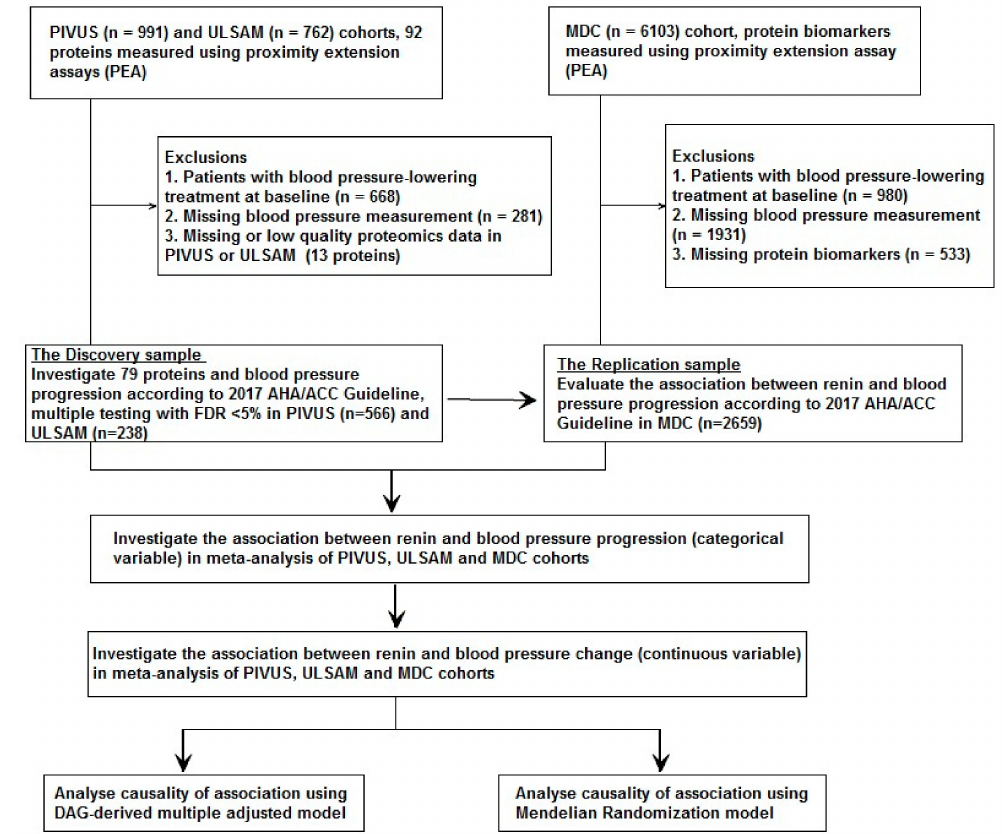
Figure 1. Study flowchart. PIVUS: Prospective Investigation of the Vasculature in Uppsala Seniors study; ULSAM: Uppsala Longitudinal Study of Adult Men; MDC: Malmö Diet and Cancer Study; AHA / ACC: American Heart Association / American College of Cardiology; FDR: false discovery rate; DAG: DAGitty.